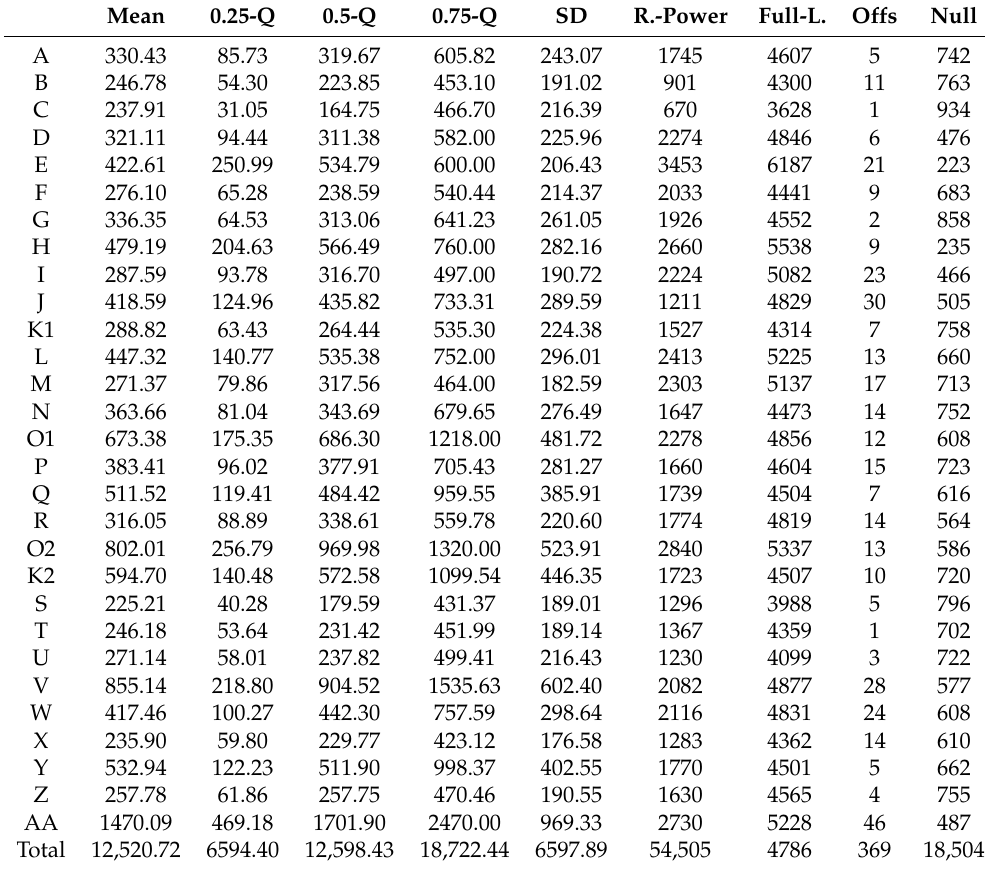
Table A4. Descriptive statistics of synthetic power production at the wind farms for the year 2000.